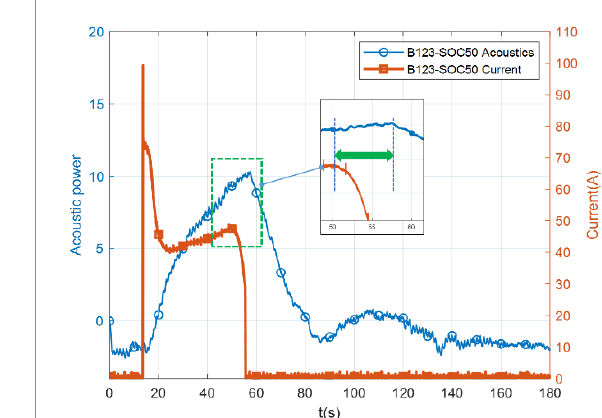
Figure 6. Current and acoustic characteristics of ESC under initial SOC50 condition.